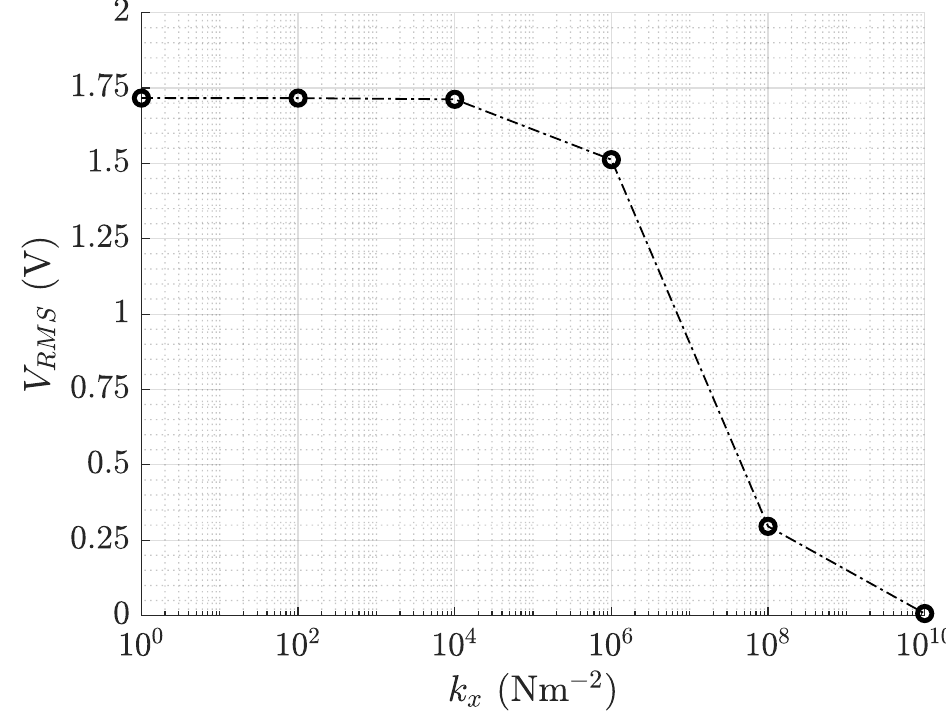
Figure 15. 𝑉 𝑆 vs. . The values of 𝑉 𝑆 were derived from the numerical OCV FRFs obtained Figure 15. V RMS vs. k x . The values of V RMS were derived from the numerical OCV FRFs obtained in COMSOL. in COMSOL.